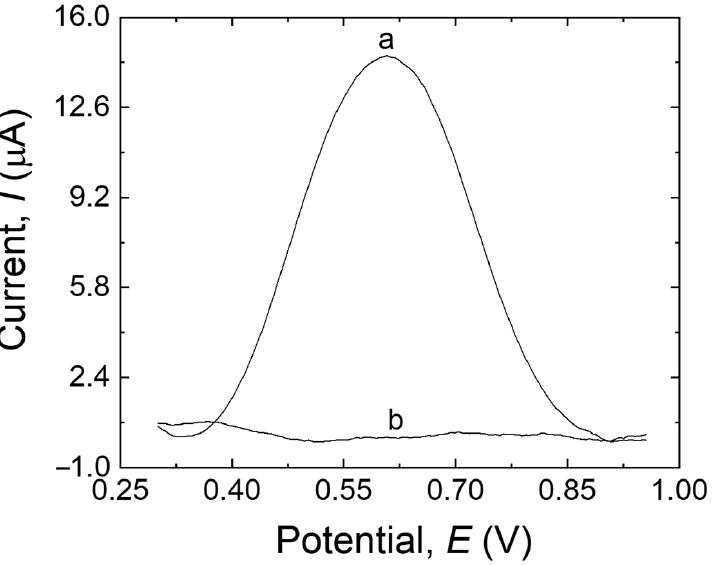
Figure 2. DPV responses of the MIP/MWCNTs/GCE before extraction (trace a) and after extraction (trace b) in 20 mL B-R buffer (pH 10.0).